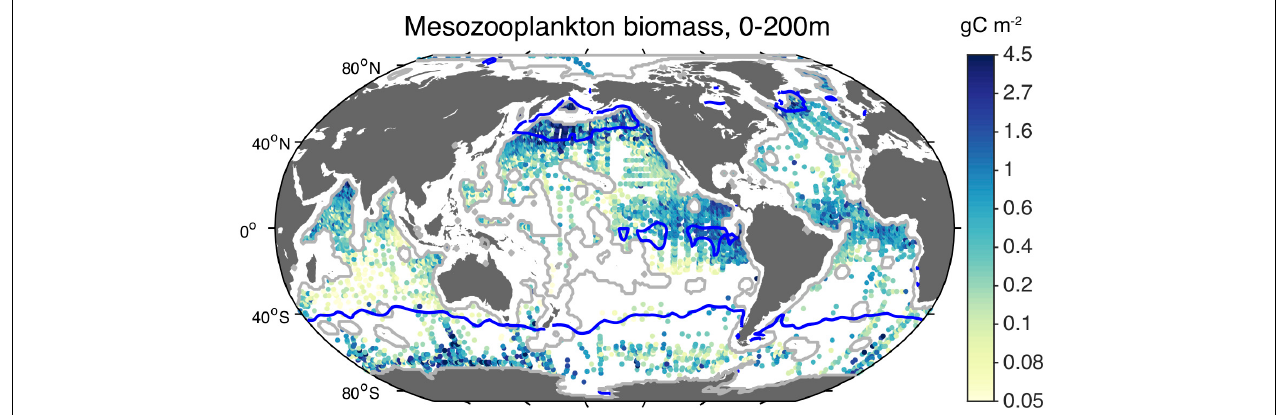
FIGURE 3 | Observed concentration of epipelagic mesozooplankton. Shaded dots indicate the average carbon concentration of mesozooplankton biomass collected in net tows within the upper 200 m of the water column (Moriarty and O’Brien, 2013). Blue contour lines indicate HNLC regions, identified as surface waters with minimum monthly nitrate concentrations > 3 µ M (Boyer,